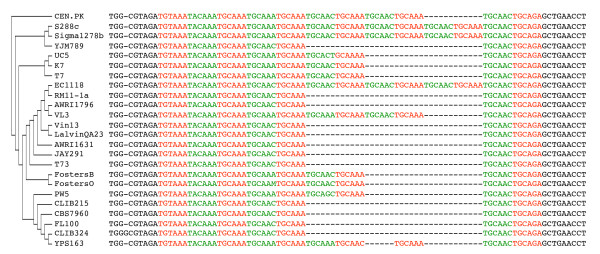
Tandem repeat variation in SNF11 amongst sequenced S. cerevisiae strains. Multiple sequence alignment of SNF11 was performed with ClustalW [56]. The cladogram was created using whole genome distances and the UPGMA algorithm. Edge lengths in the cladogram are meaningless. Genbank accessions are listed in Additional file 12: Table S7.